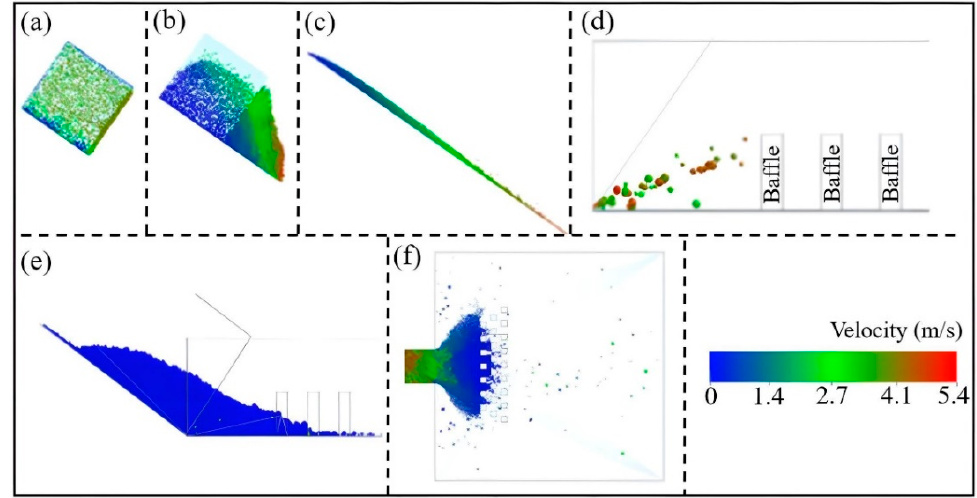
Figure 14. The impact of debris flow particles on a cluster of Z1 baffles: ( a ) t = 0 s; ( b ) t = 0.3 s; ( c ) t = 1.1 s; ( d ) t = 1.3 s; ( e ) t = 2 s; ( f ) t = 4